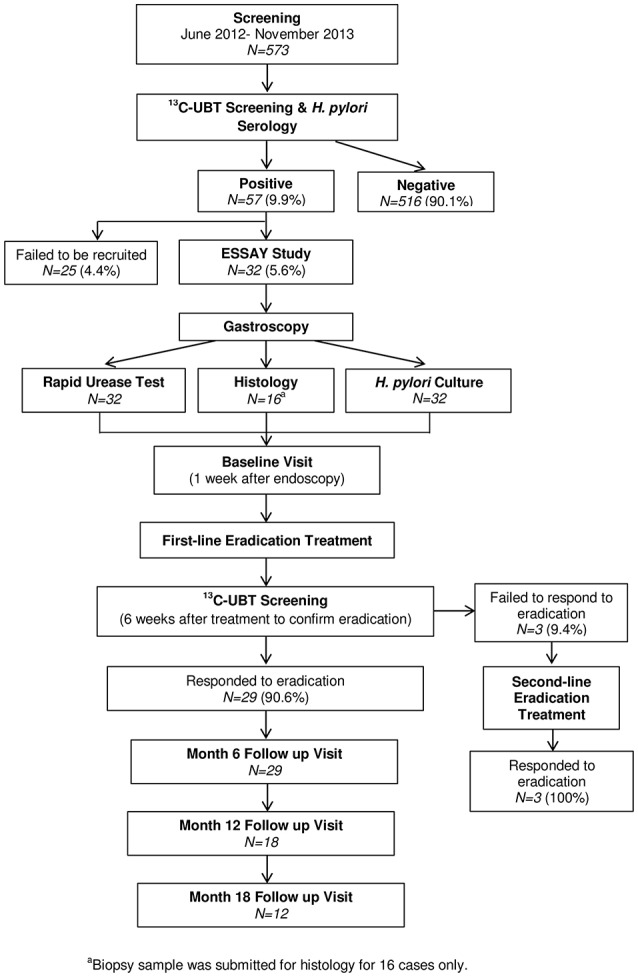
Summary of ESSAY Study (Yap et al., 2015).